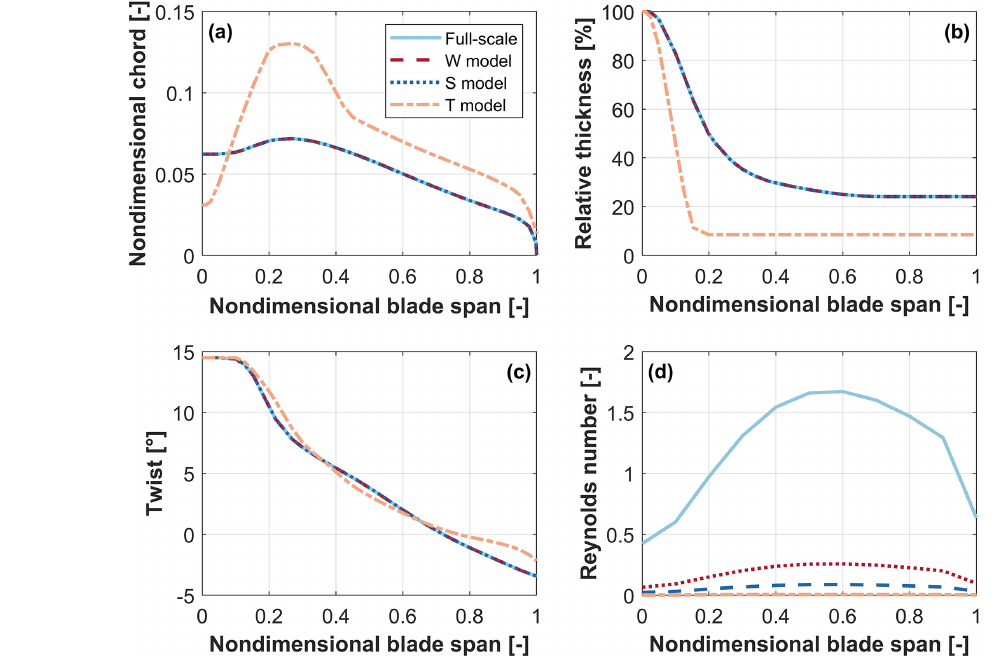
Figure 2. (a) Nondimensional chord, (b) relative thickness, (c) twist, and (d) Reynolds number vs. spanwise position for the full-scale blade and its three subscale